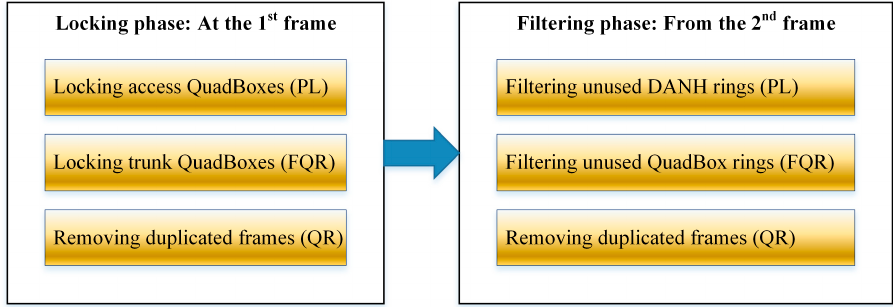
Figure 11. The operational diagram of effectively filtering approach (EFA).